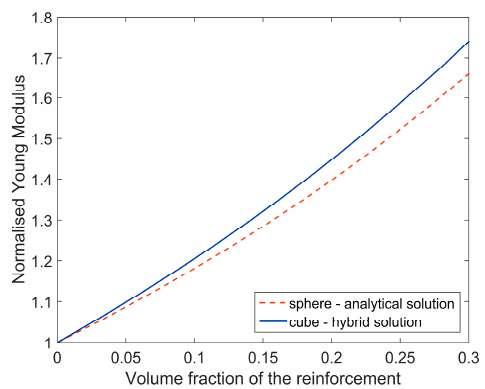
Figure 11. Normalized Young moduli in terms of volume fraction of the reinforcement determined by using pure analytical and hybrid method.